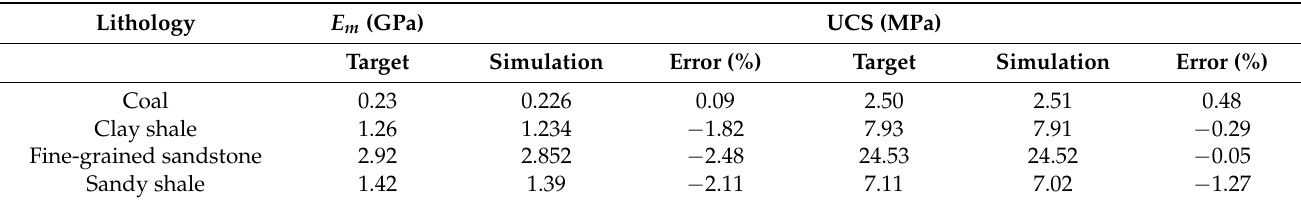
Table 4. Comparison between the targeted and simulated rock mass